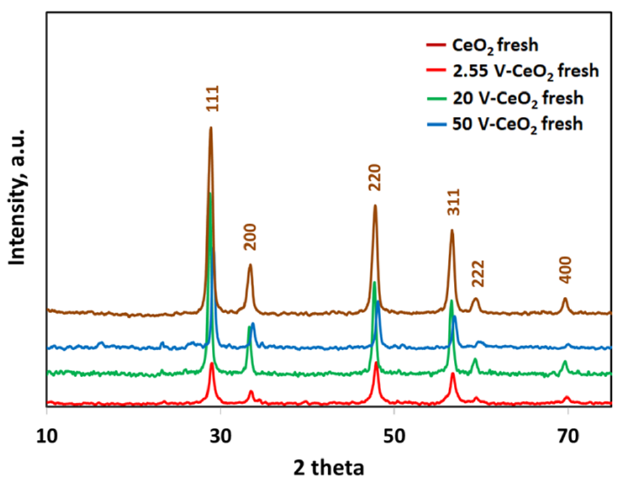
Figure 7. XRD spectra of CeO 2 and 2.55, 20, 50 V-CeO 2 fresh catalysts.